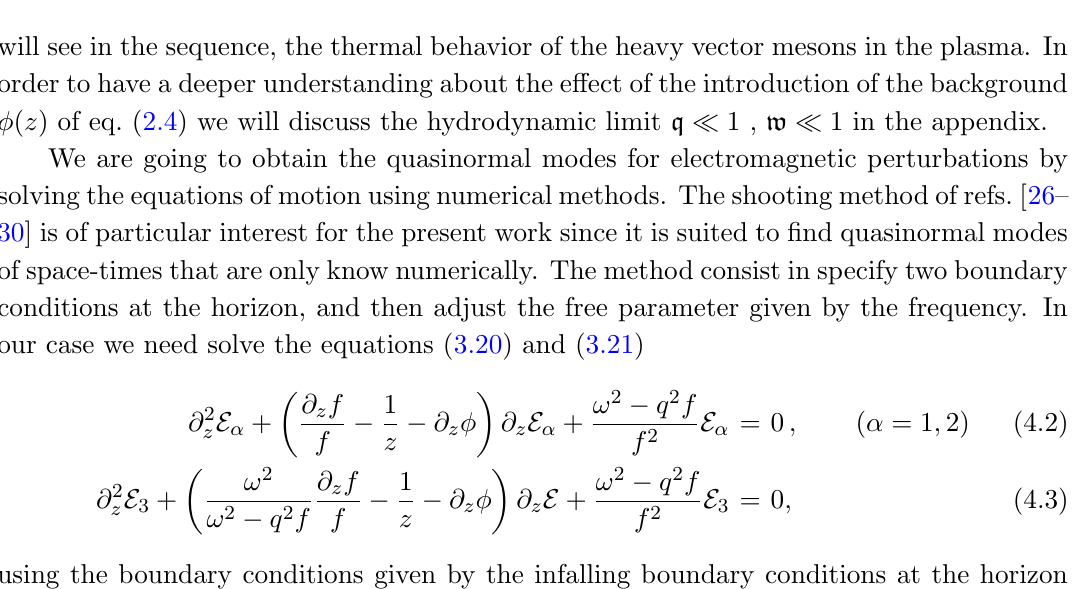
Figure 6 . Real and imaginary parts of the frequencies of bottomonium quasinormal modes as function of the temperature. The real part of the frequencies is shown on the left side, and the imaginary part on the right